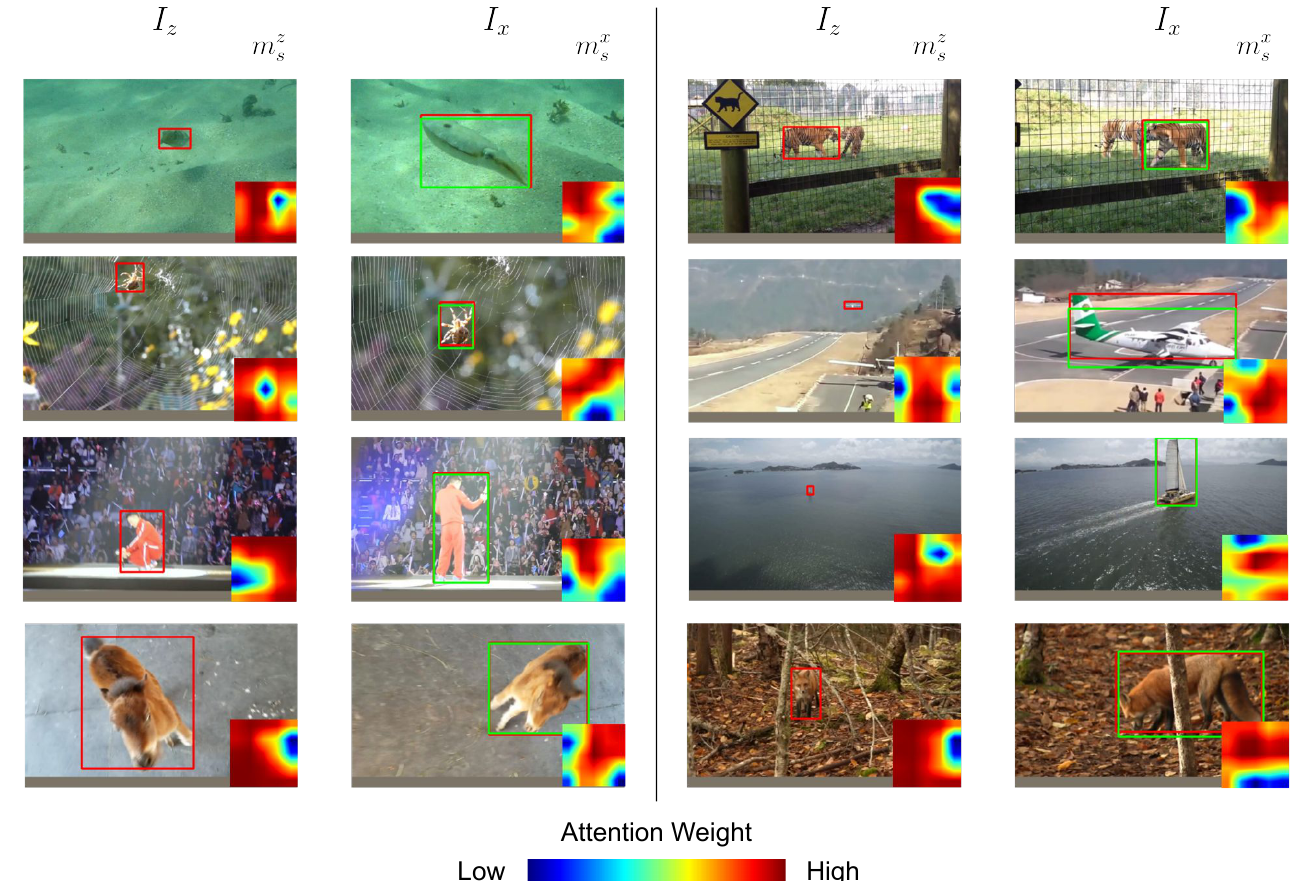
Figure 7. Visualization of spatial attention masks on the LaSOT test